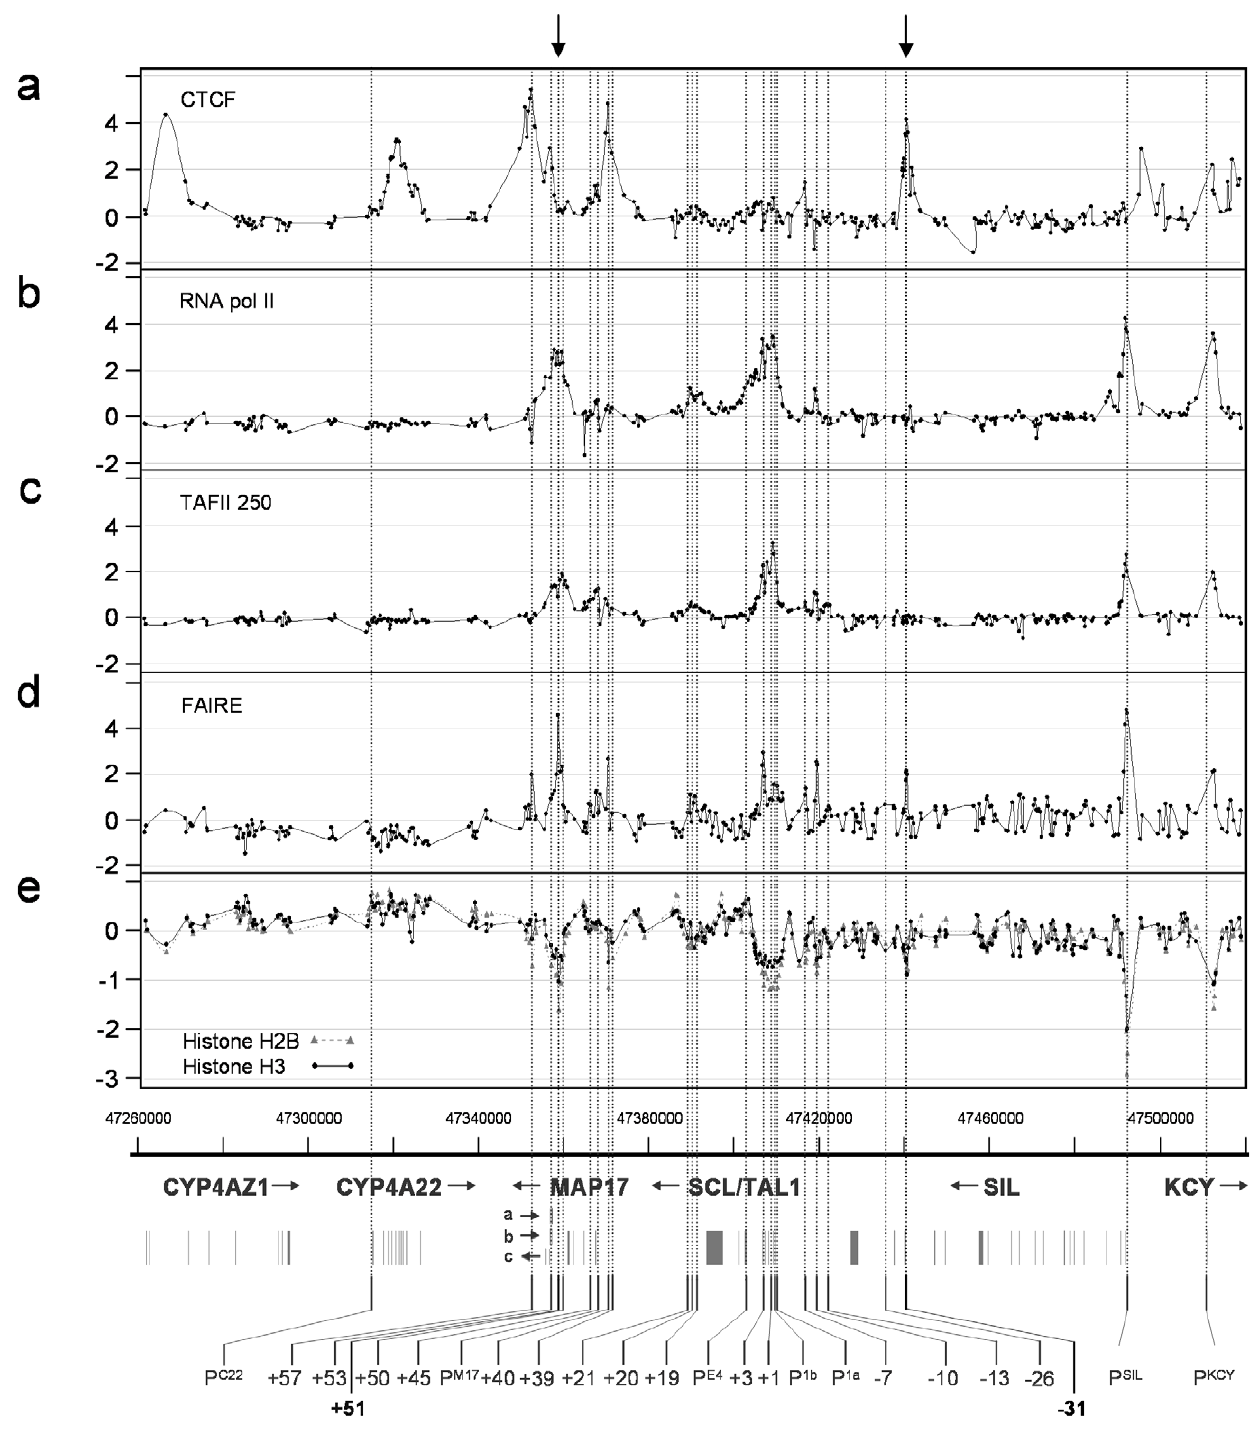
Figure 2. CTCF, PolII and TAFII 250 binding, chromatin accessibility and nucleosome density profiles across the human SCL locus in the K562 cell line. Assays used are named at the left of each panel. Dots on the solid joined-up lines represent the data obtained for each genomic tiling array element. In panel E, the profiles for histone H2B and histone H3 are shown as dotted joined-up line with triangles and solid joined-up lines with dots for H2B and H3 respectively. All other aspects of the figure are as in Figure 1. doi:10.1371/journal.pone.0009059.g002 agreement with these models. ChIP-chip profiles in K562 cells for inability to detect sub-types of nucleosomes (using standard ChIP the nucleosomal components histone H3 and histone H2B were methods) [46] may be a general feature of active genes and their compared with the results of our FAIRE chromatin fractiona- active regulatory sequences in eukaryotic genomes. We found tion assays (Figure 2). FAIRE assays allow DNA segments which that nucleosome architecture at the human SCL locus was in